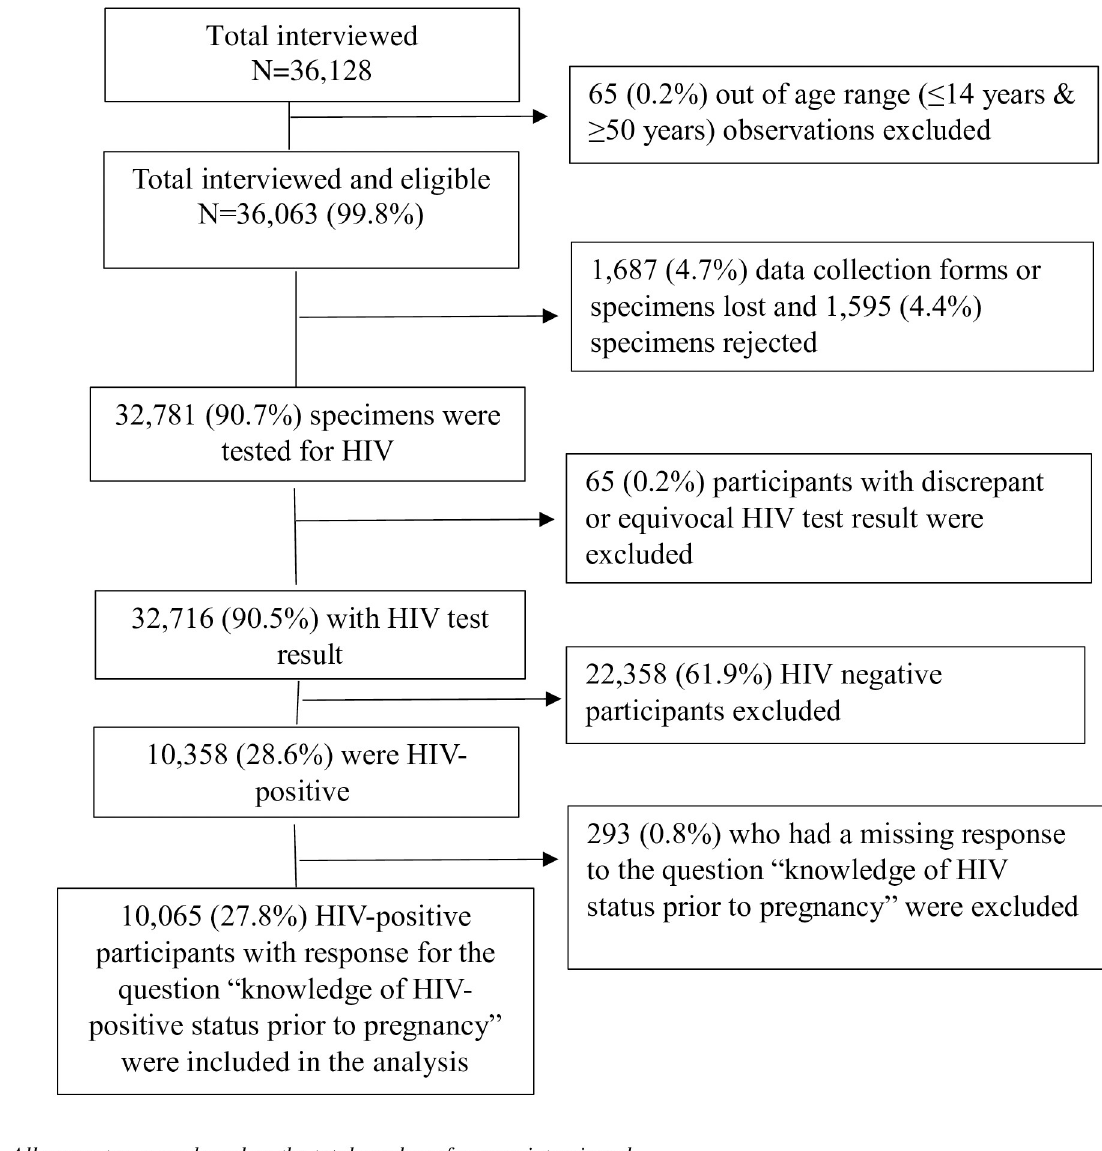
Fig 1. Flow chart of observations excluded from the analysis, national antenatal sentinel survey, 2017.